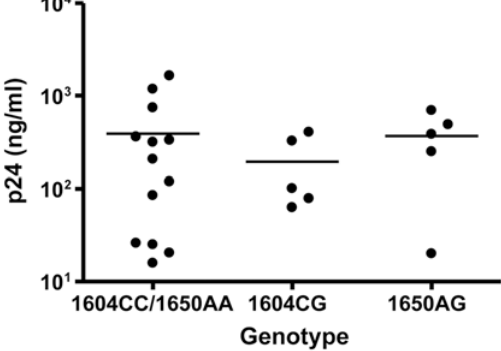
Figure 3. Analysis of HIV-1 replication in genotyped PBMC. Replication of NL4-3 Ba-L in PHA stimulated PBMC from healthy donors homozygous for the 1604 and 1650 major allele (1604CC/1650AA), heterozygous for the 1604 minor allele (1604CG), or heterozygous for the 1650 minor allele (1650AG). Virus replication was analyzed by measuring p24 production in culture supernatant. P24 production at day 12 after infection is shown.